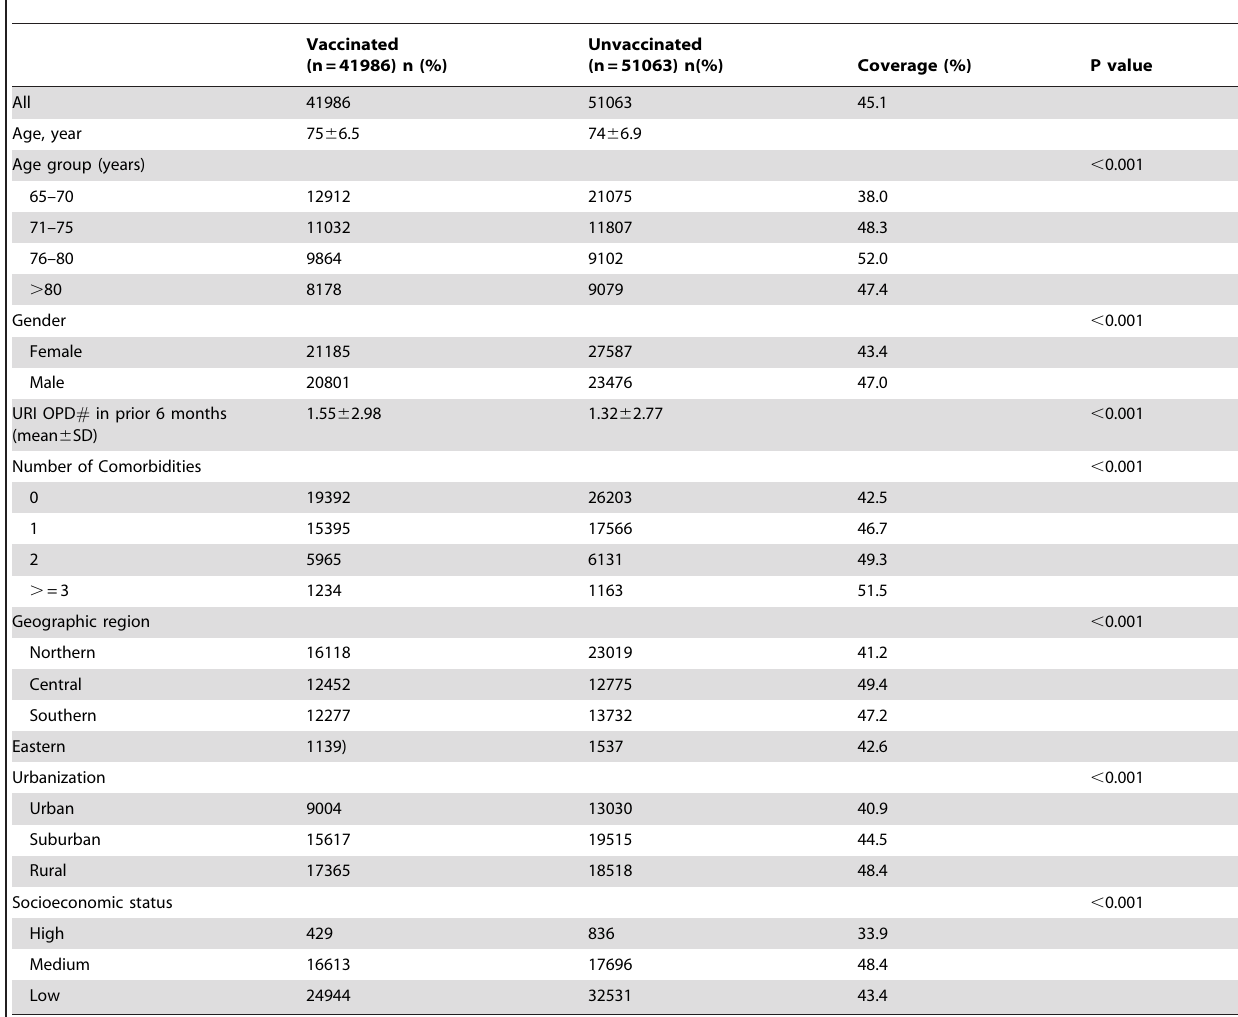
Table 1. Numbers and percentage proportions of vaccine coverage by sex, comorbidities, geographic regions and urbanization of residence, and individual socioeconomic status